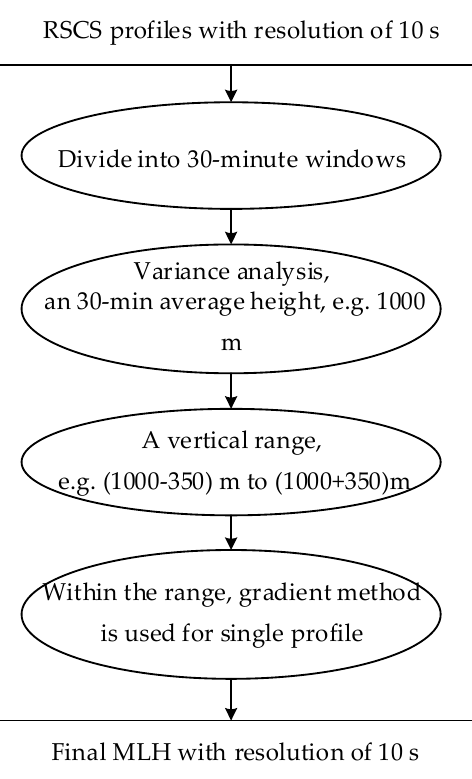
Figure 9. Flowchart for the combination of the VAR and GM in Hennemuth and Lammert [42]. In addition, combined the GM and VAR, Martucci et al. [119,120] proposed the temporal-height-tracking (THT) algorithm. The time series of CBLH can be determined by